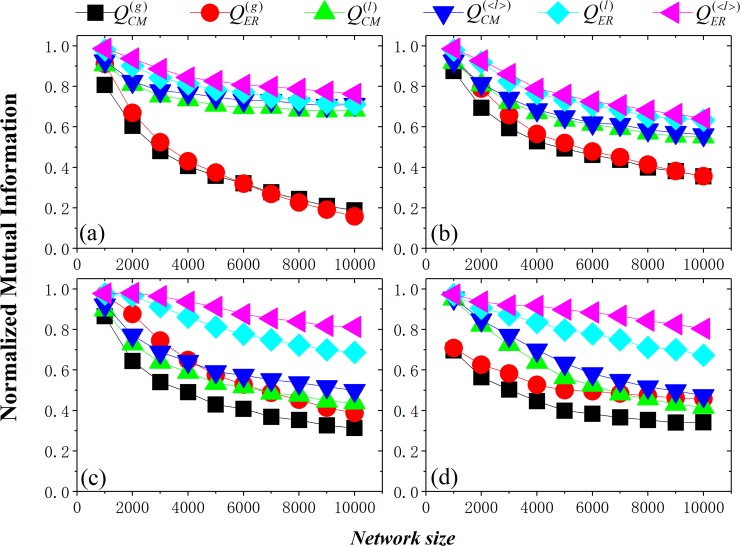
NMI obtained by different modularity as network size in the NET3 networks.Parameters of networks: (a) kmax=30, cmax=50; (b) kmax=30, cmax=150; (c) kmax=100, cmax=150; (d) kmax=0.015 N, cmax=0.020 N. (see Table 1 for details of network parameters).